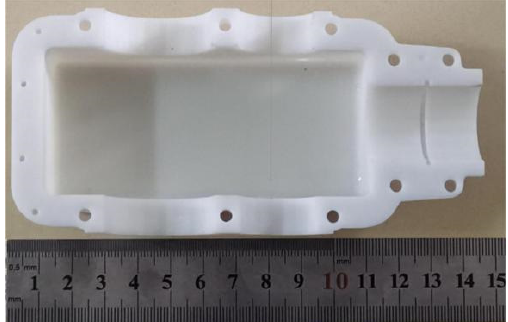
Figure 7. The printed lower teeth.